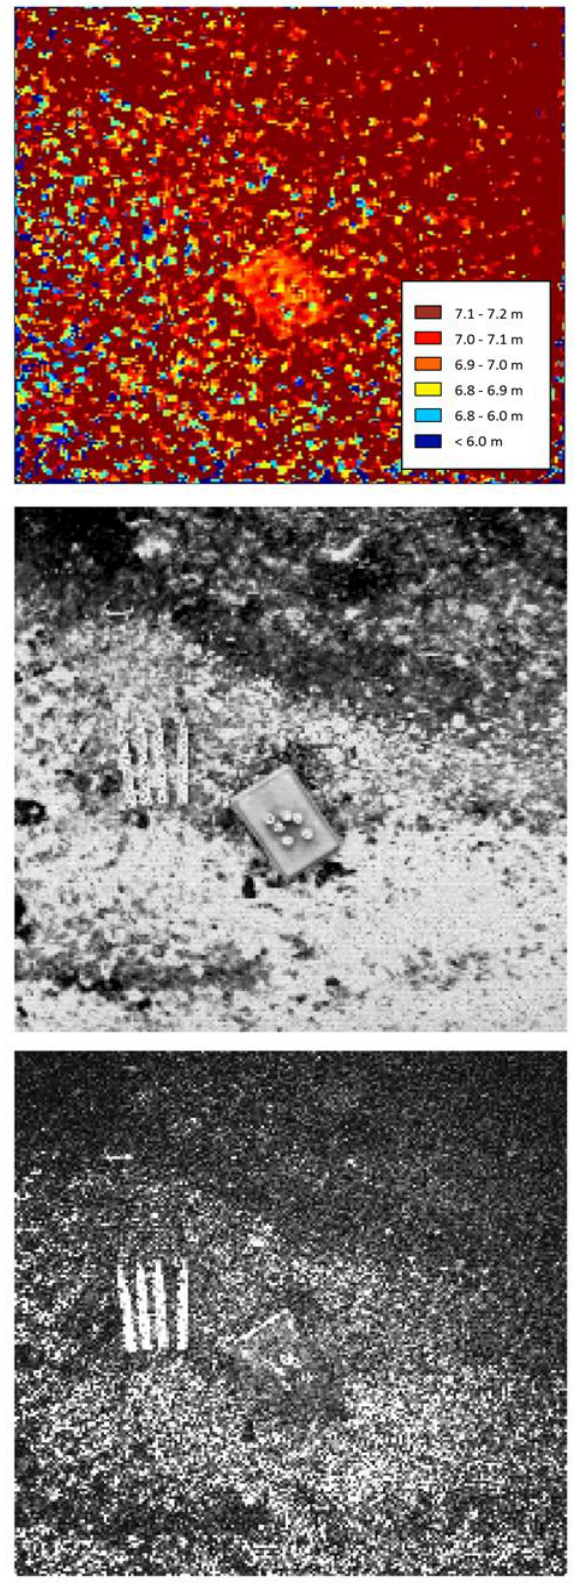
Figure 7 aerial range image (5 m flight height) top: median filtered single distance image, middle: single intensity image, bottom: single amplitude